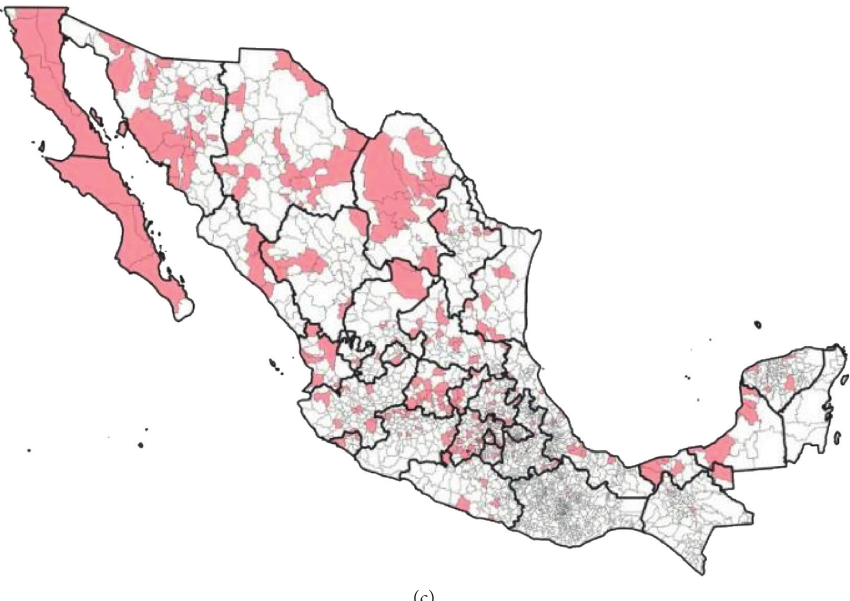
Figure 4: Maps of Mexico for deaths, contagion, and suspected cases. (a) Deaths. (b) Contagion. (c) Suspected